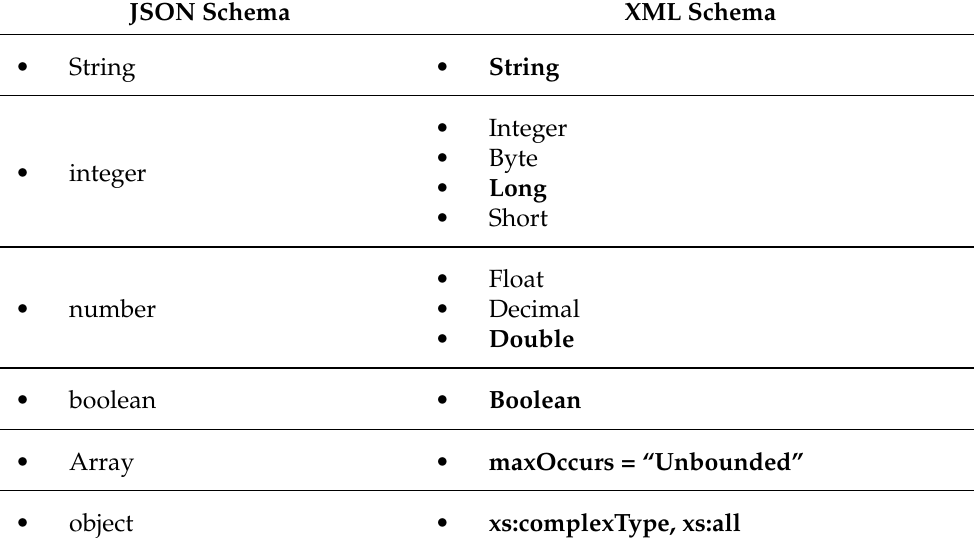
Table 1. JSON Schema to XML Schema data type compatibility